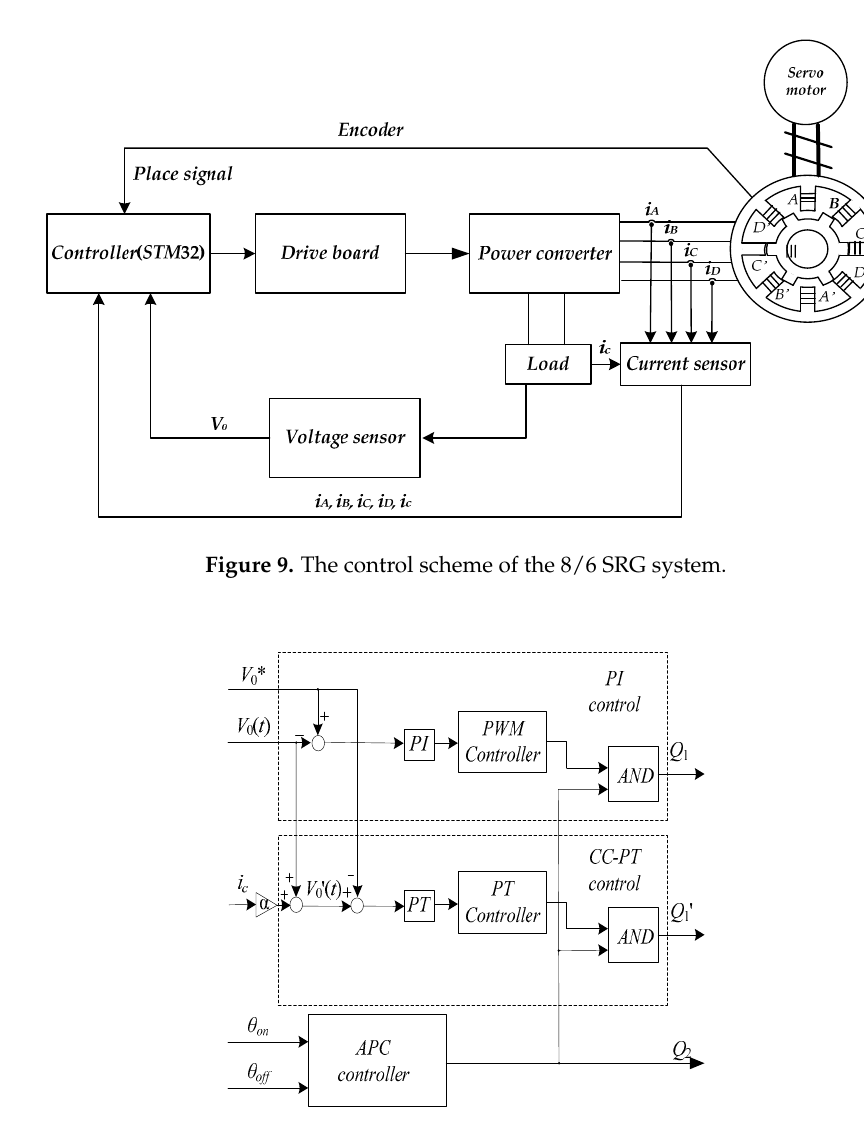
Figure 10. SRG controller.